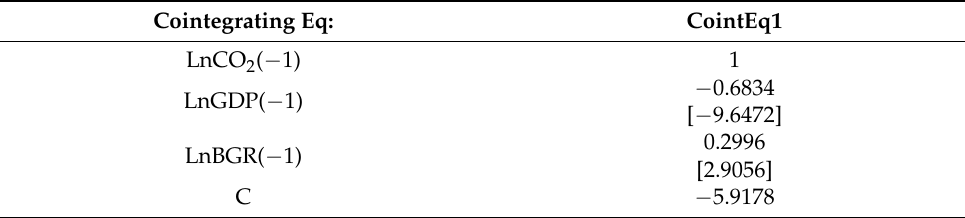
Table 12. Cointegration equations for the vector error correction models.